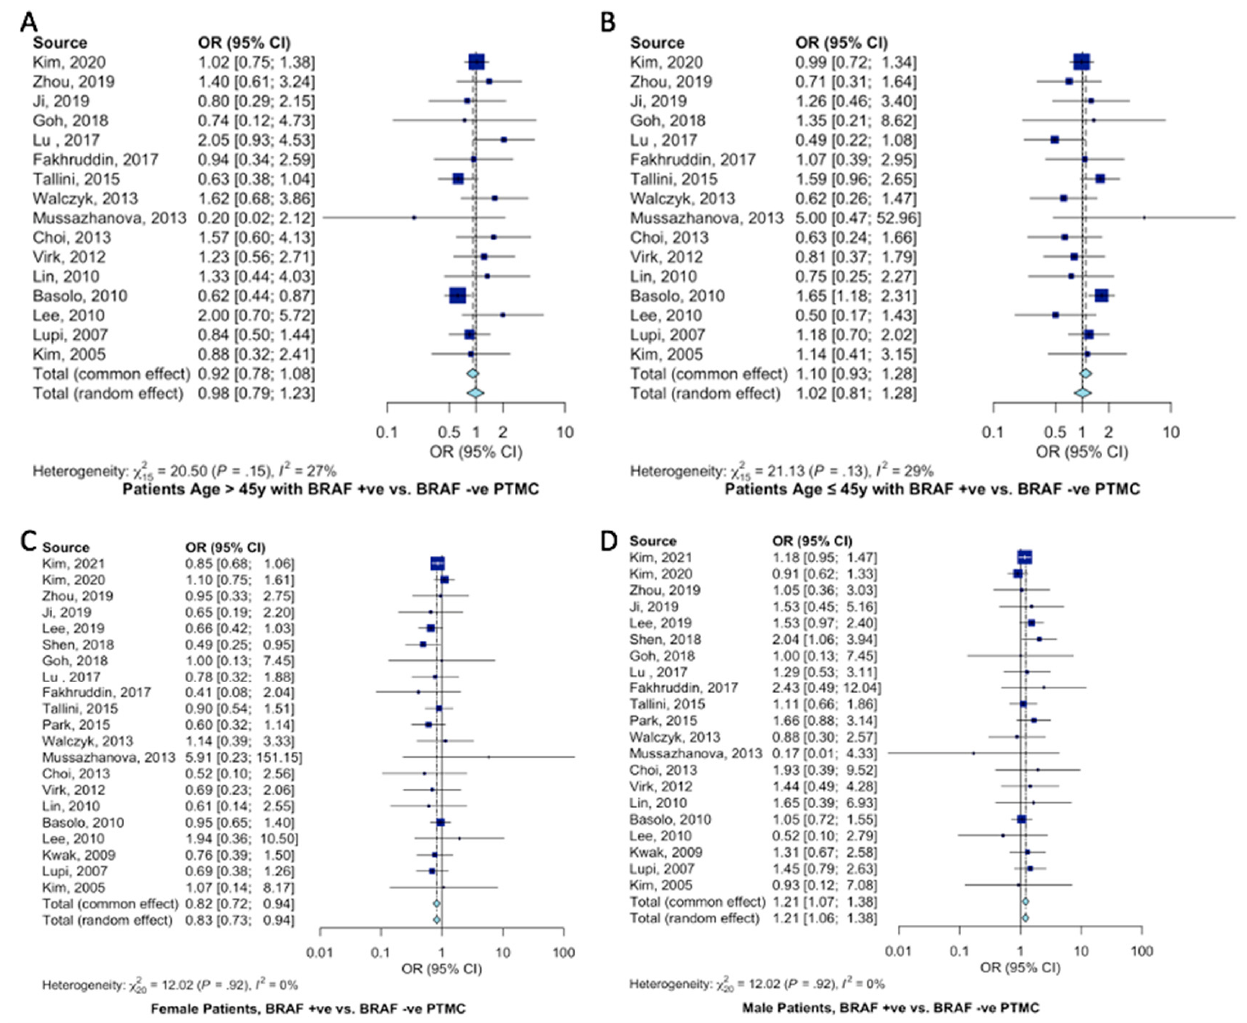
Figure 2. Meta-analysis of demographic characteristics and association with BRAF V600E mutation. Forest plot for ( A ) older patients (>45 years) [11,12,15,19–22,26,27,29,30,34–36,41,42], ( B ) younger patients ( ≤